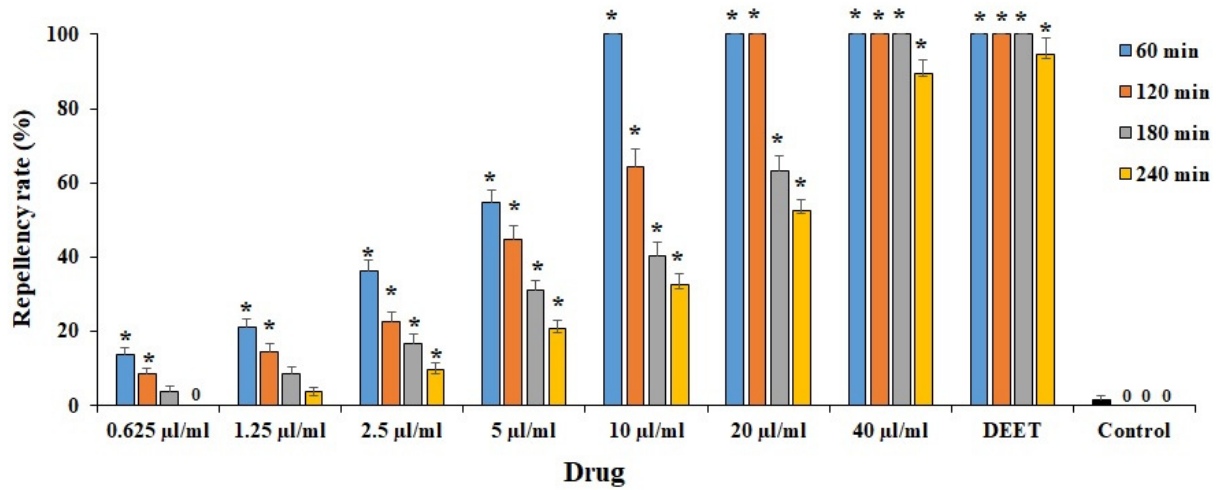
Figure 4. The effects of various concentrations of Elettaria cardamomum L. essential oil (ECEO) on the repellent activity against Hyalomma anatolicum larvae after different incubation times. Data are stated as mean ± SD (n = 3). * p < 0.001 significant difference with control group. DEET: (N,N-diethyl-3-methylbenzamide, 7.5%).